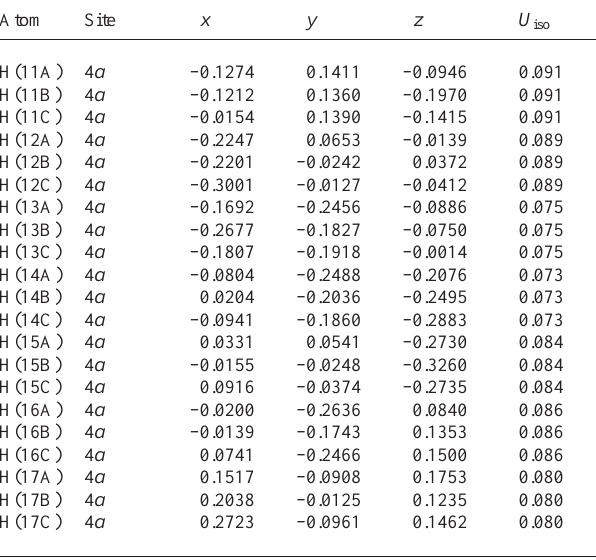
Table 2. Atomic coordinates and displacement parameters (in Å 2 )